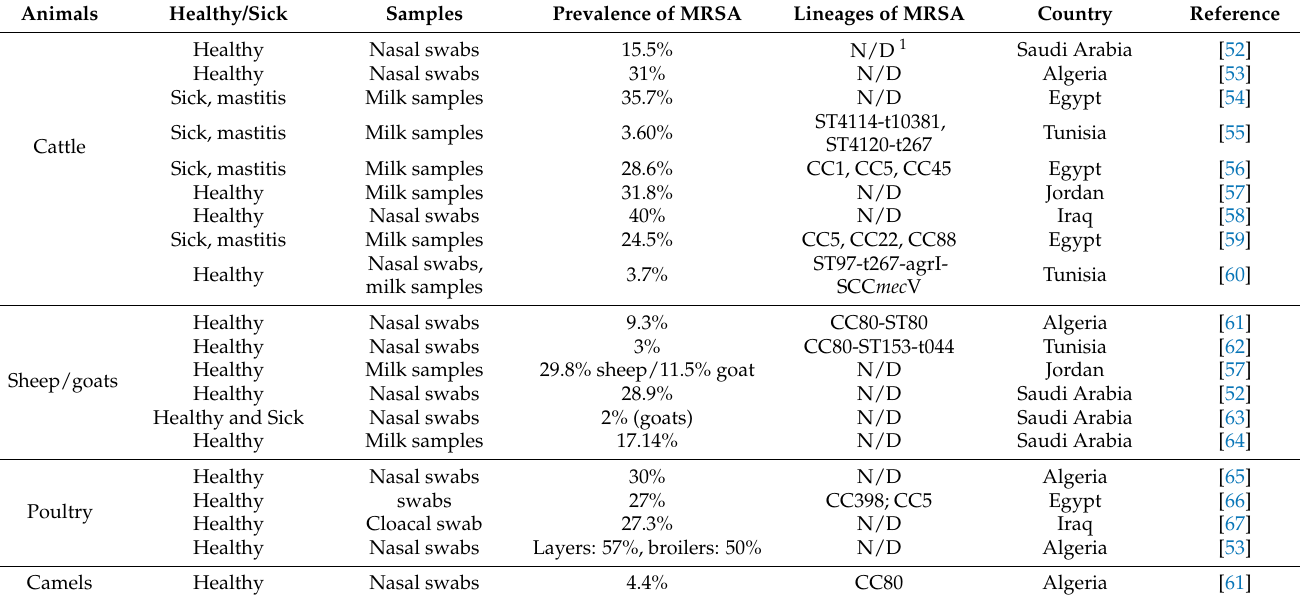
Table 2. Prevalence of methicillin-resistant Staphylococcus aureus (MRSA) in food-producing animals in different Arab